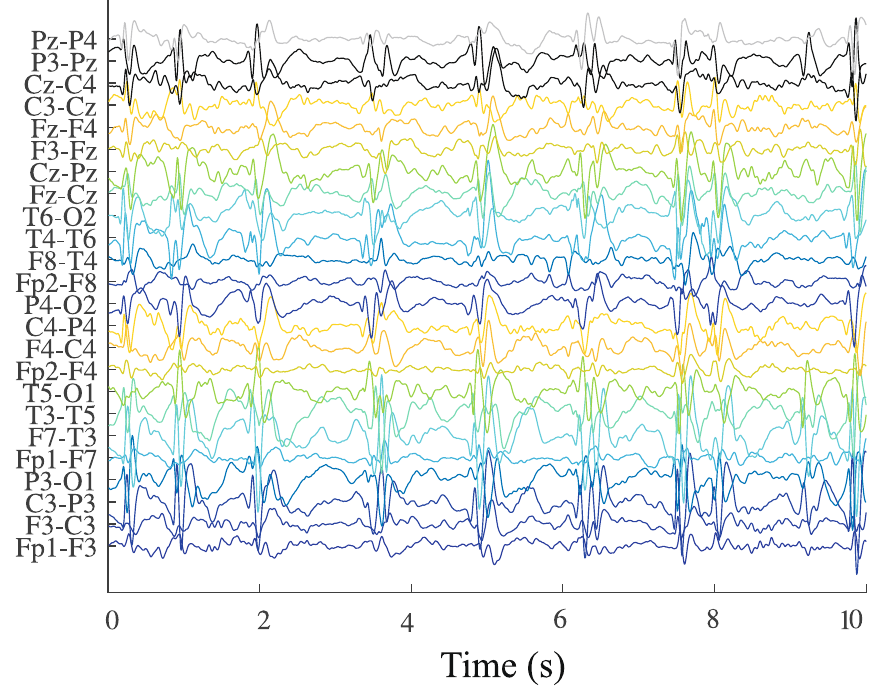
Figure 2. Hypsarrhythmic segments Zika virus congenital